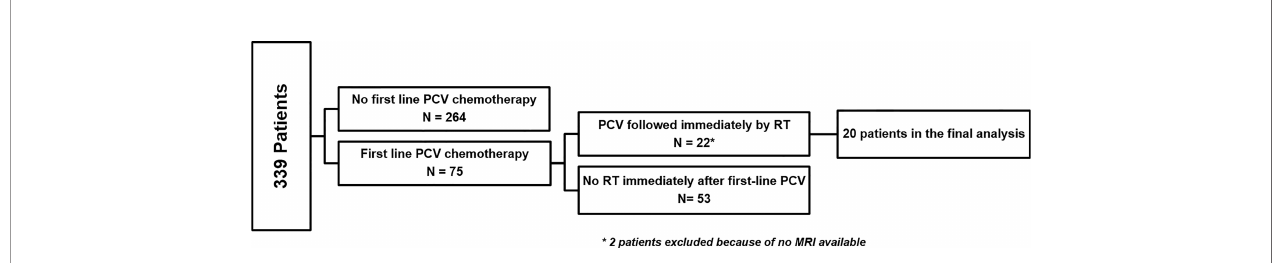
FIGURE 1 | Flowchart of patient selection from the